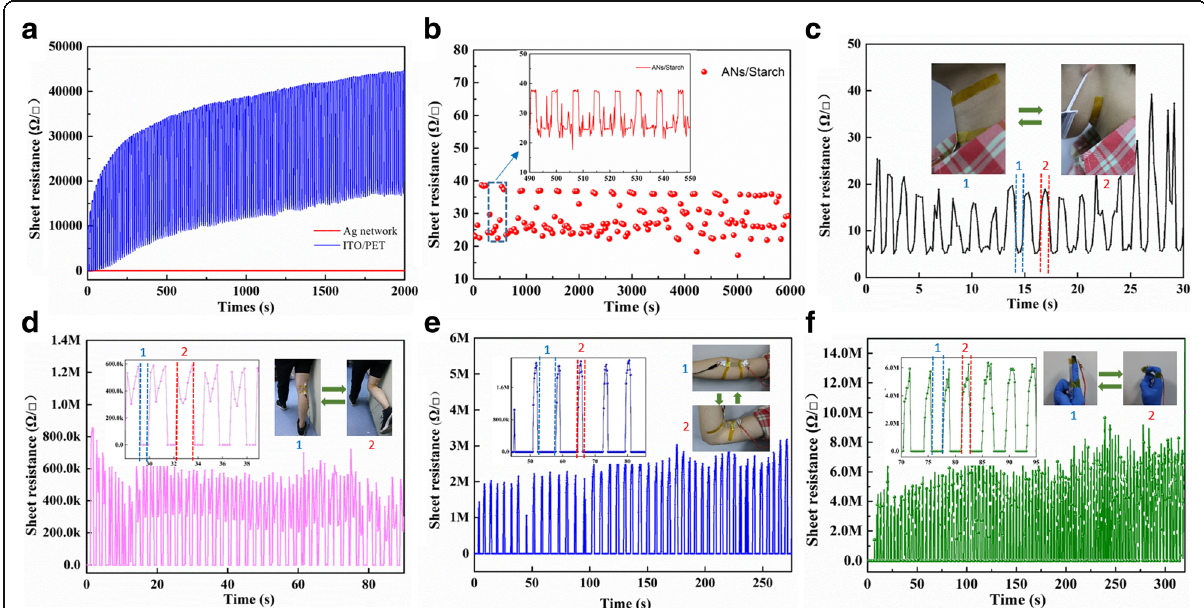
Fig. 4 Flexibility demonstration of the SAN based sensor. a Comparison of sheet resistance as a function of bending time. b An enlarged figure of a ; inset shows the detailed variation of sheet resistance of the SAN sensor from 490 to 550 s. c – f Characterization of sensors bending at different part of human body: c neck, d knee, e elbow, and f finger. Insets: photographs of the sensors attached to different part of human